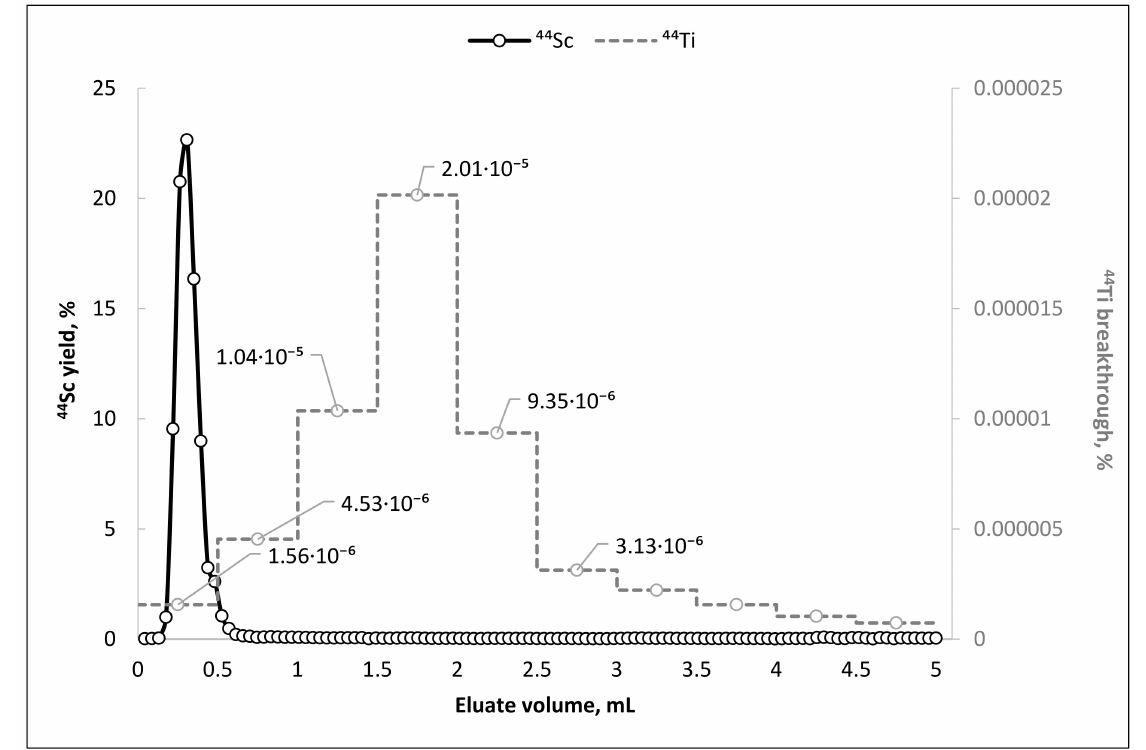
Figure 3. Typical elution curve of 44 Sc from TEVA-based 44 Ti/ 44 Sc generator (primary axis) and values of 44 Ti breakthrough in eluate fractions (0.5 mL each fraction; secondary axis), eluent—0.1 M H 2 C 2 O 4 /0.2 M HCl, flow rate—1 mL/min.